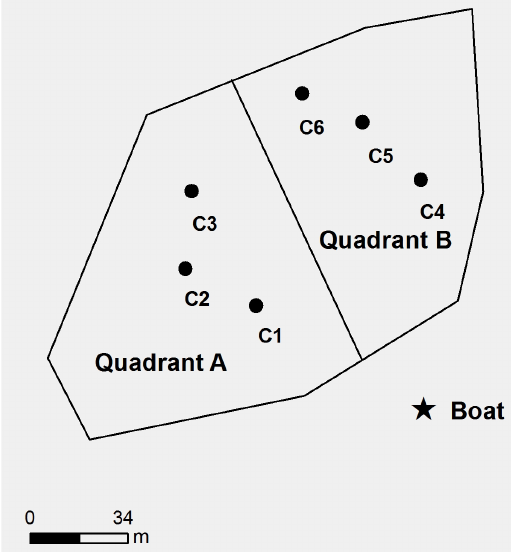
Figure 3. Los Pozos: Quadrants and Artificial Feeder observation